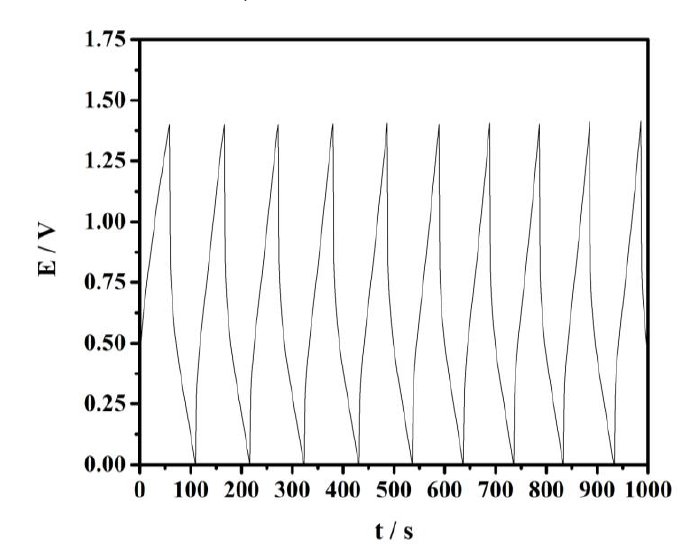
Figure 8: GCD curves obtained for the redox capacitor (charging and discharging current: 100